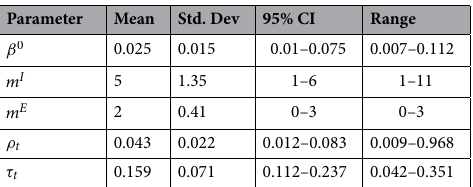
Table 1. Parameter estimates from UIUC SHIELD data.